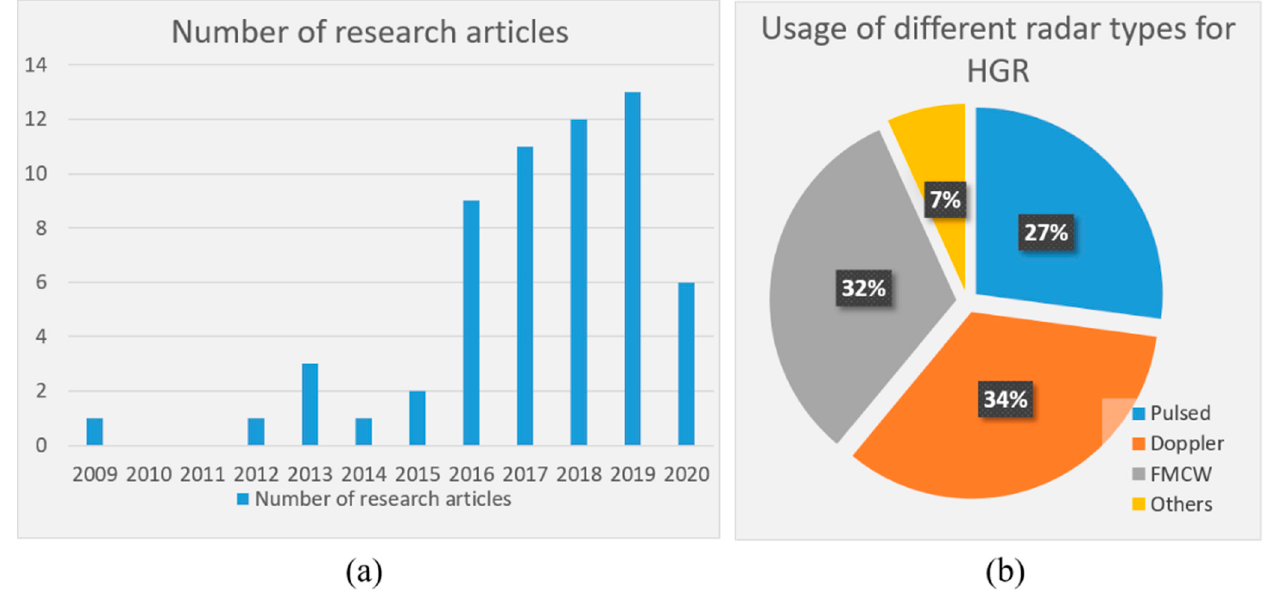
Figure 11. Performed quantitative analysis for HGR ( a ) Number of research articles written per year ( b ) usage of different types of radar technologies for